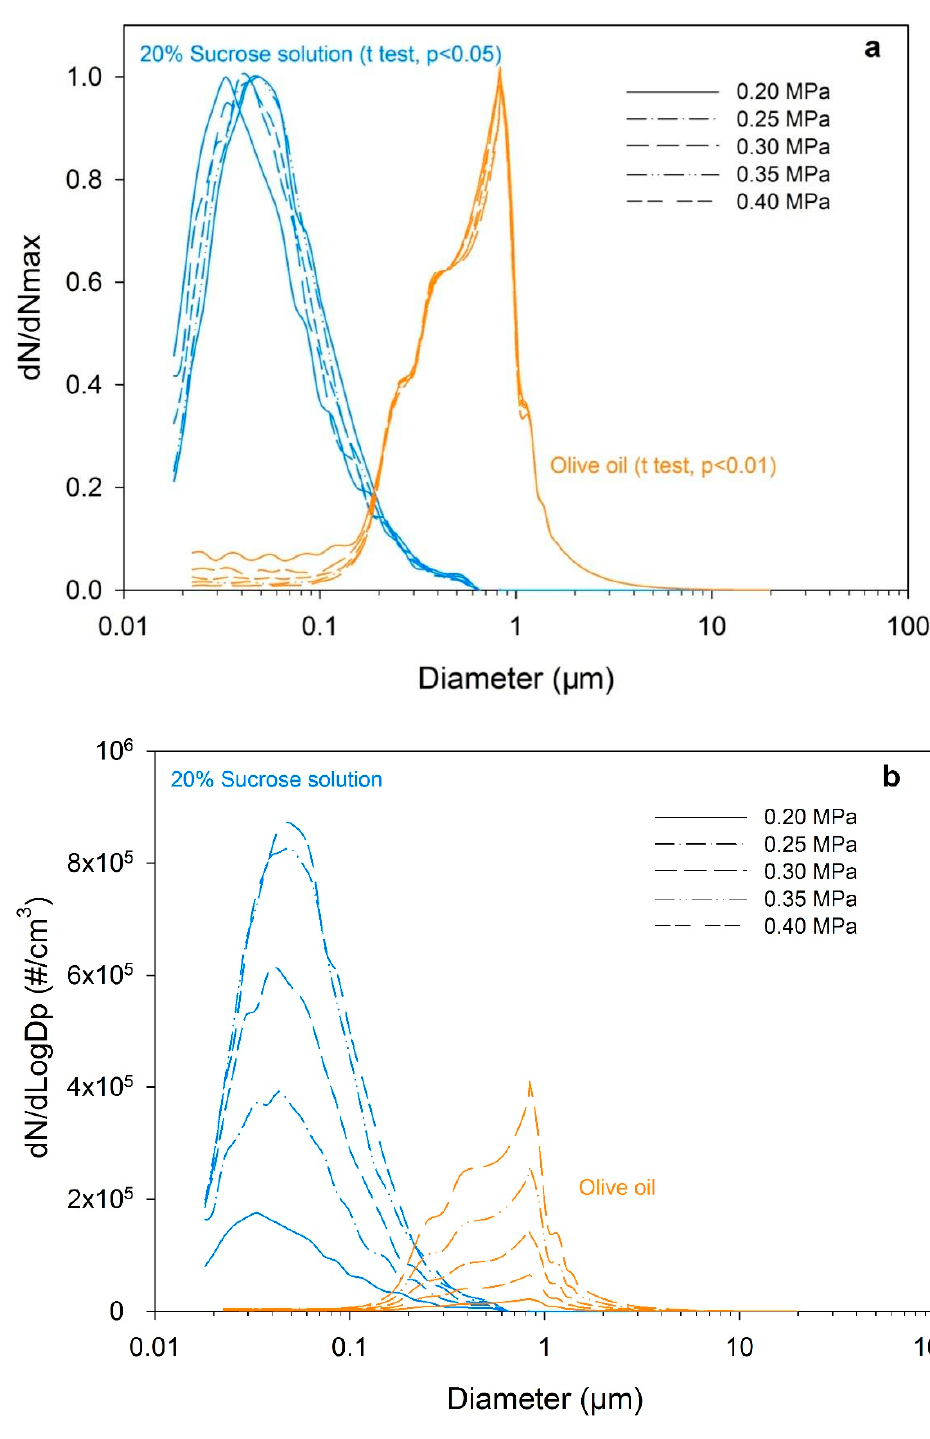
Figure 3. Influence of compressed air’s pressure on the normalized size distribution ( a ) and size distribution ( b ) of particles generated by sucrose solution and olive oil.